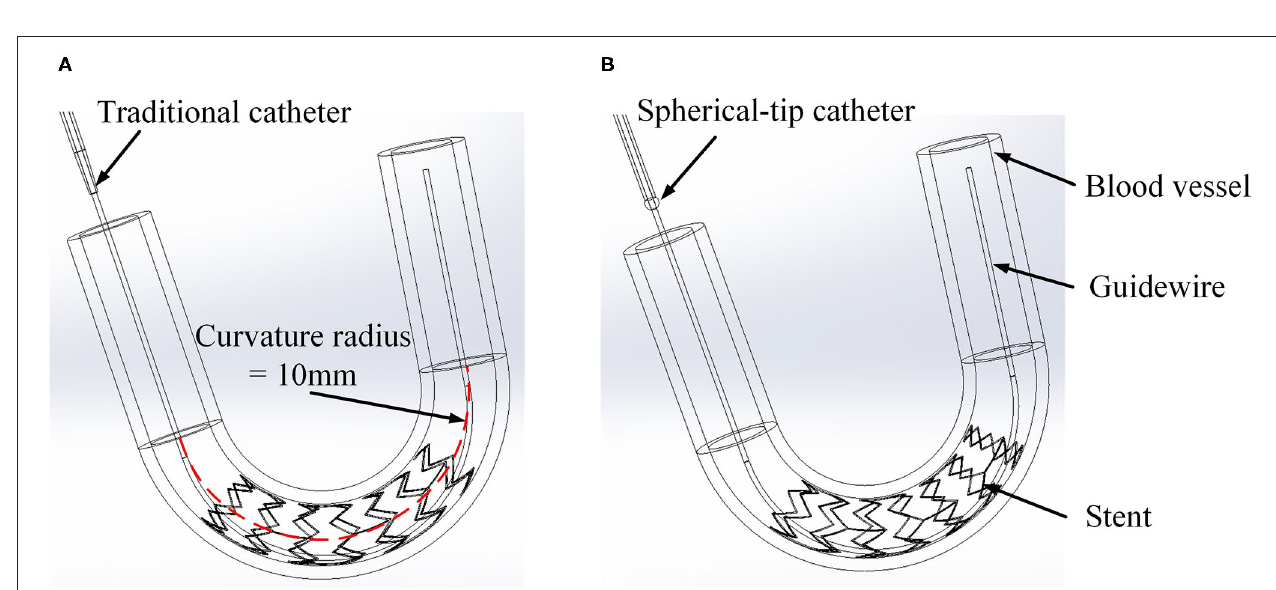
FIGURE 6 | Three-dimensional FE models of catheter, stent, and vessel. (A) Traditional catheter model and (B) spherical-tip catheter model.